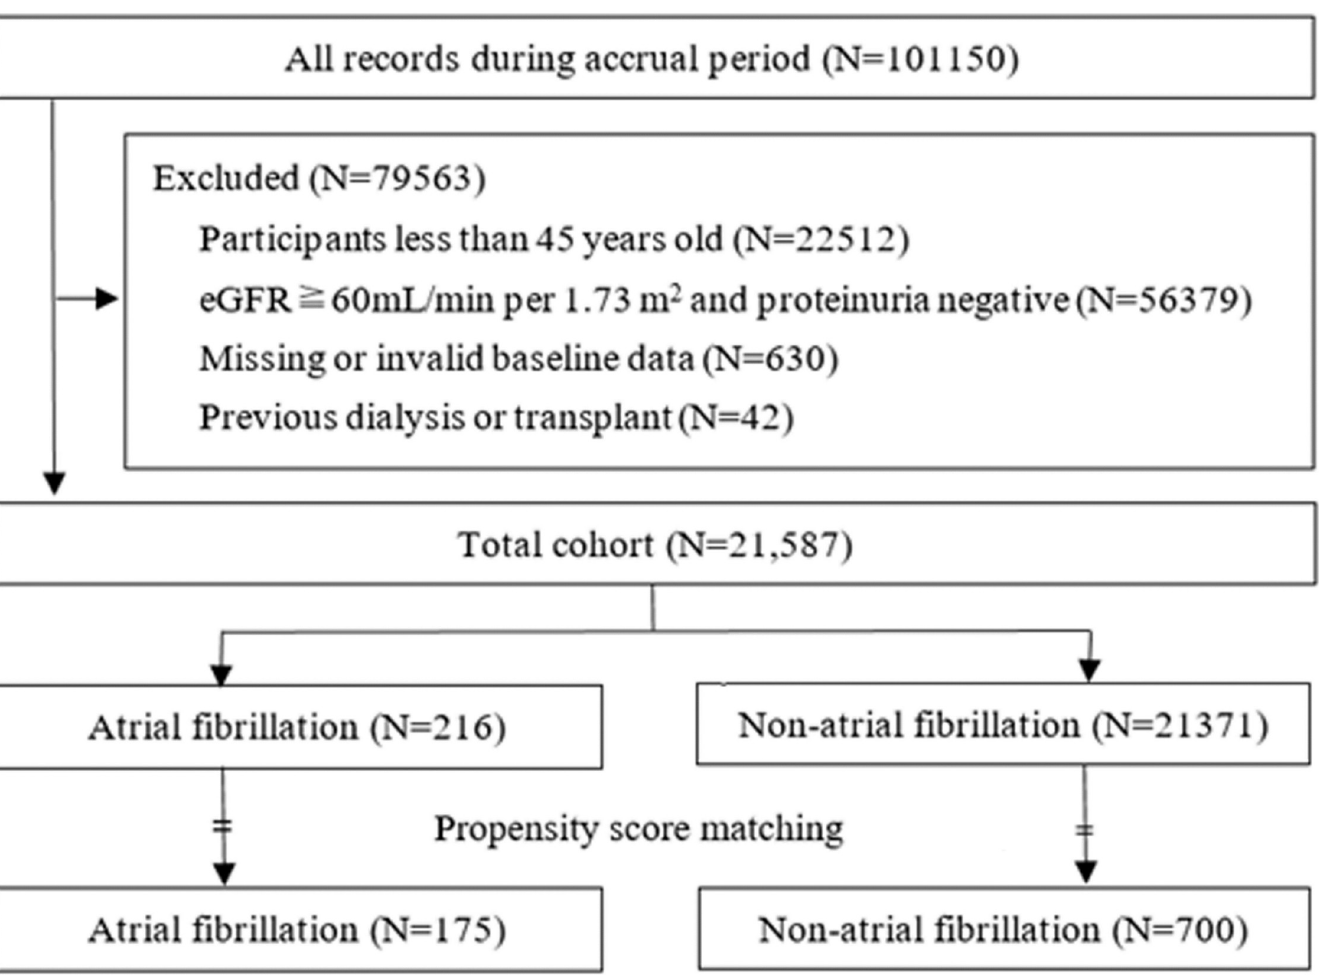
Fig 1. Flowchart of participant